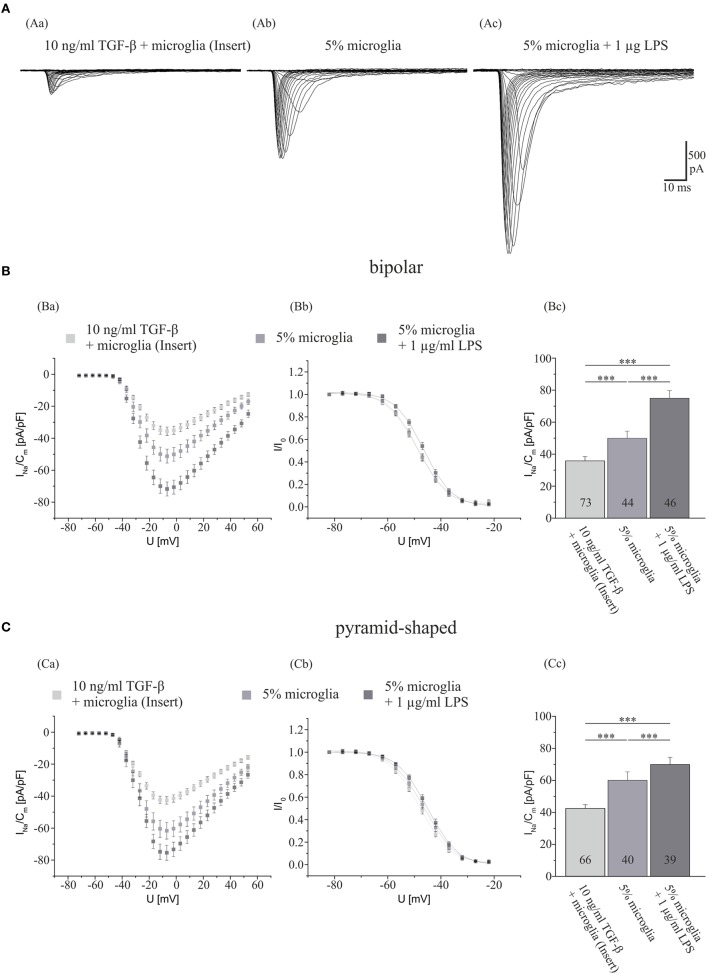
Influences of LPS exposure for 4 days and TGF-β exposure for 7 days in the presence of microglia on Na+ current density of cultured hippocampal neurons. (A) Series of original Na+ current recordings from bipolar neurons elicited by step depolarizations in 5 mV increments starting from a holding potential of −77 mV after the different treatments. Analysis of the whole data set for (B) bipolar and (C) pyramid-shaped cells. (Ba,Ca) Average current–voltage relationships for Na+ currents normalized to capacitance recorded from neurons cultured in the presence of microglia and either 4 days of exposure to 1 μg LPS or 7 days of exposure to TGF-β. (Bb,Cb) Influence of TGF-β and LPS on steady-state inactivation of Na+ currents. Solid lines represent fits to the modified Boltzman equation as detailed in Section “Materials and Methods.” (Bc,Cc) Peak Na+ current densities of neurons cultured in the presence of microglia and either 4 days of exposure to 1 μg/ml LPS or 7 days of exposure to TGF-β determined at test potentials of −12 mV starting from holding potentials of −77 mV. All recordings performed at day 7 in culture. Numbers in bar charts indicate numbers of cells recorded from. Database for every column derived from 7 to 10 different preparations. Error bars represent means ± SE, *p < 0.05, **p < 0.01, and ***p < 0.005.